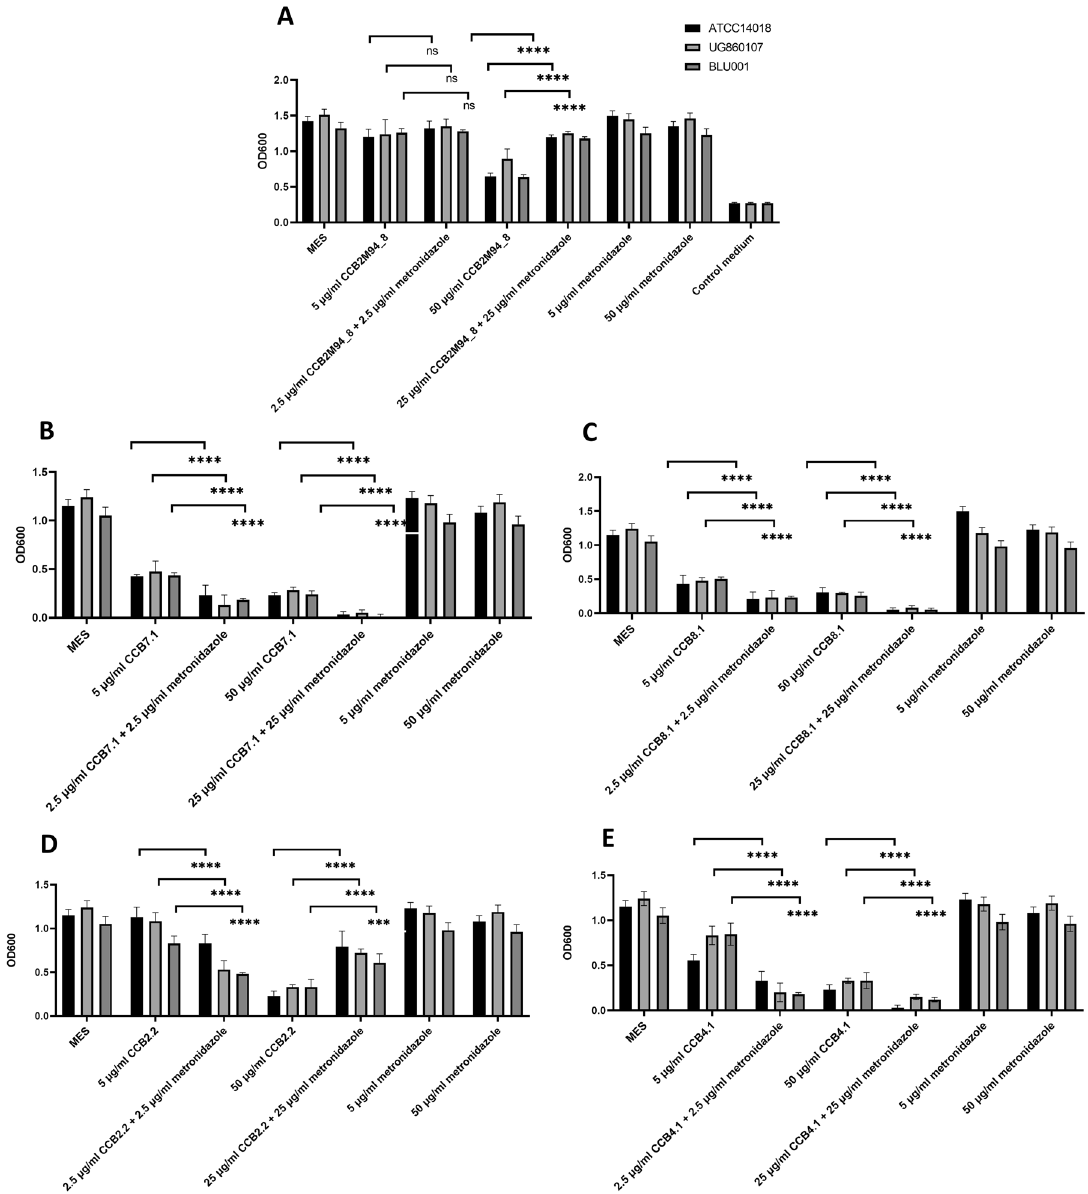
Fig. 6 Synergistic activity : Bio fi lm disruption assay using G. vaginalis ATCC14018, G. vaginalis UG860107 and G. vaginalis BUL001 pre- established bio fi lms. Final concentrations of A CCB2M94_8, B CCB7.1, C CCB8.1, D CCB2.2 or E CCB4.1 ranged from 2.5 to 50 μ g/ml, were used to disrupt bio fi lms. OD 600 readings are the average of biological triplicates plus/minus their standard deviation. The asterisks in fi gures indicate levels of signi fi cance. p -values < 0.05 are represented by *, p- values < 0.01 are represented by **, p -values < 0.001 are represented by *** and p -values < 0.0001 are represented by ****. No statistical differences are represented by ns. Controls: MES corresponds to bacteria with MES buffer and control medium is the no bacterial control. p -values for ANOVA and Tukey